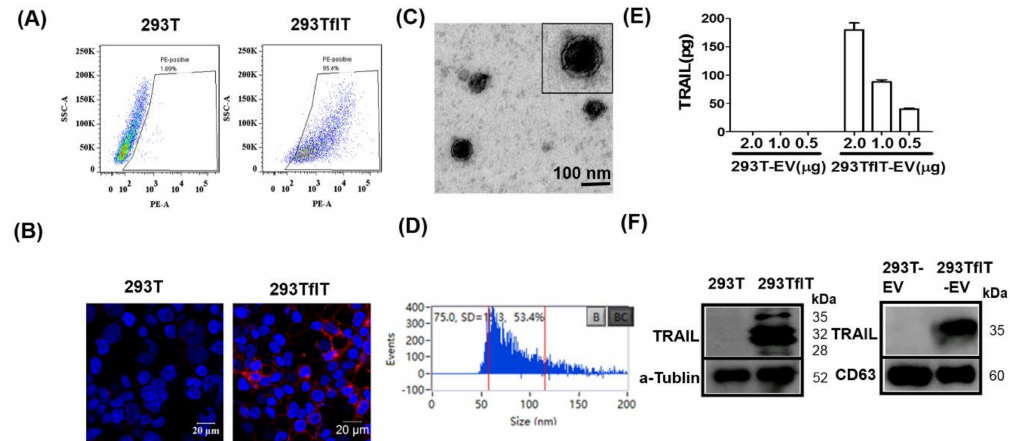
Figure 1. Generation and characterisation of TRAIL-loaded EVs (TRAIL-EVs). ( A ) Flow cytometry analysis of TRAIL expression in 293T cells transfected by empty virus (293T) or TRAIL-expressing lentiviruses (293TflT); ( B ) Immunofluorescent detection of TRAIL expression (red) by a PE-anti human TRAIL antibody in 293T and 293flT cells with nuclei labeled as blue by DAPI; ( C ) Electron microscopy of EVs isolated and purified by ultra-centrifugation of 0.22 µ m filtering cleared supernatant of 293TflT cells grown in EV-depleted FBS containing medium; ( D ) Assessment of size distribution of isolated EVs by a Flow Nanoanalyzer that can detect nanoparticles with size ranging from 7 to 1000 nm; ( E ) Measurement of TRAIL expression levels in EVs derived from 293T (293T-EV) or 293TflT(293TflT-EV) using a commercial TRAIL-specific ELISA kit. Values are mean ± S.E.M ( n = 3). ( F ) Western blotting detection of TRAIL, tetraspanin CD63 and loading control protein alpha-tubulin in EVs or cellular lysates; for each sample 10 µ g of cellular or EV proteins were